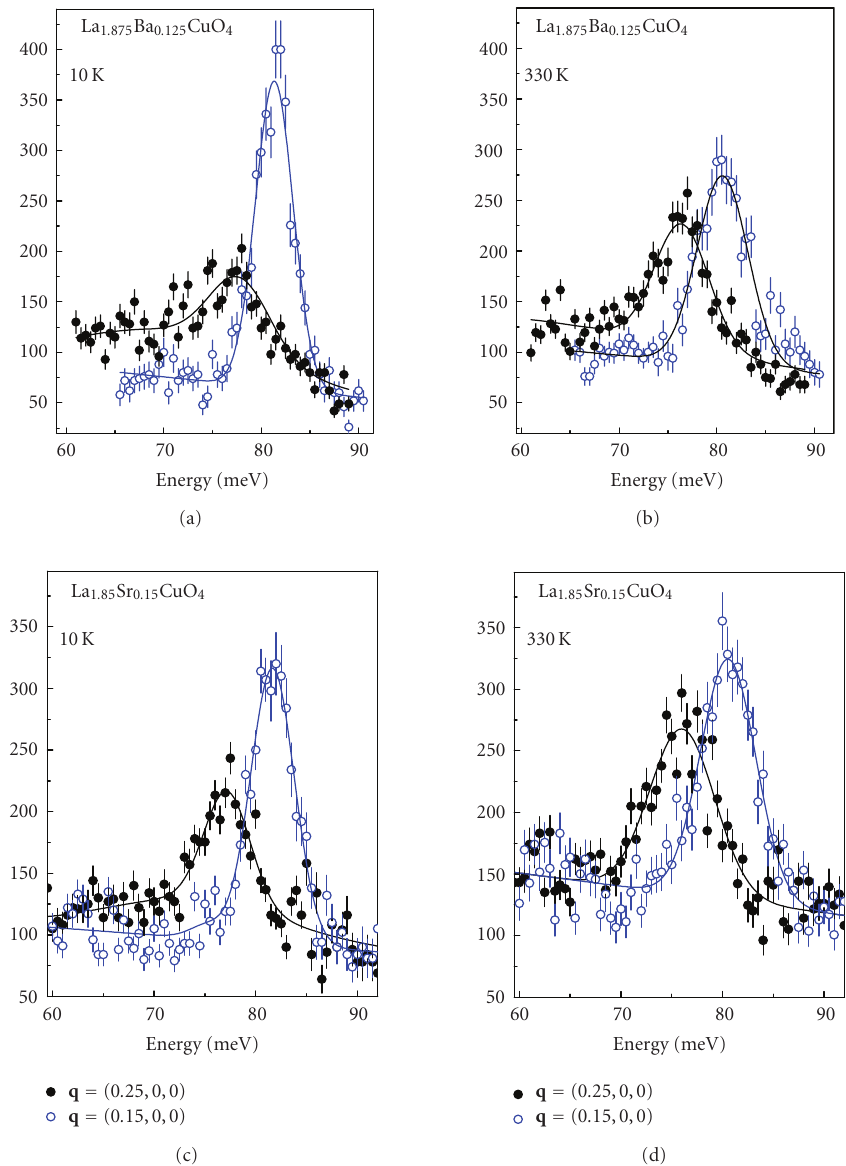
Figure 11: Temperature dependence of the bond-stretching phonons at select wavevectors. Energy scans taken on La 1 . 875 Ba 0 . 125 CuO 4 (a, b) and on La 1 . 85 Sr 0 . 15 CuO 4 (c, d, e) at 10K (a, c) and 330 K (b, d) [37]. The phonon at q = (0 . 15,0,0) is “normal” in that it has a Gaussian lineshape on top of a linear background. This background results from multiphonon and incoherent scattering and has no strong dependence on Q . The intensity reduction of this phonon in La 1 . 875 Ba 0 . 125 CuO 4 from 10K (a) to 330 K (b) is consistent with the Debye-Waller factor. At q = (0 . 25,0,0), there is extra intensity on top of the background in the tail of the main peak. It originates from one-phonon scattering that extends to the lowest investigated energies, while the peak intensity is greatly suppressed as discussed in the text. The e ff ect is reduced but does not disappear at 330K. Note that 330 K in (b) is shown instead of 300K in the same plot in [37] because of a typographical error in the latter. Integrated intensity of the phonon decreases from q = (0 . 15,0,0) to q = (0 . 25,0,0) due to the decrease of the structure factor.